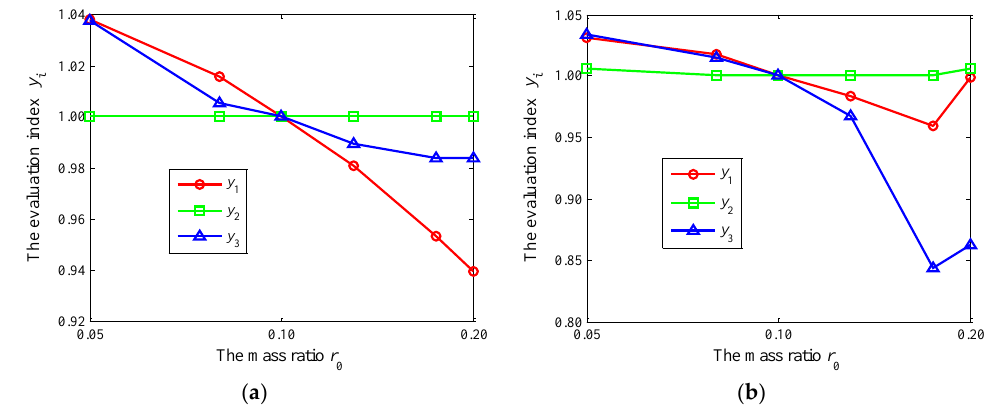
Figure 13. The evaluation index y i versus the mass ratio r 0 for the wheelchair: ( a ) going up the step; ( b ) going down the step.